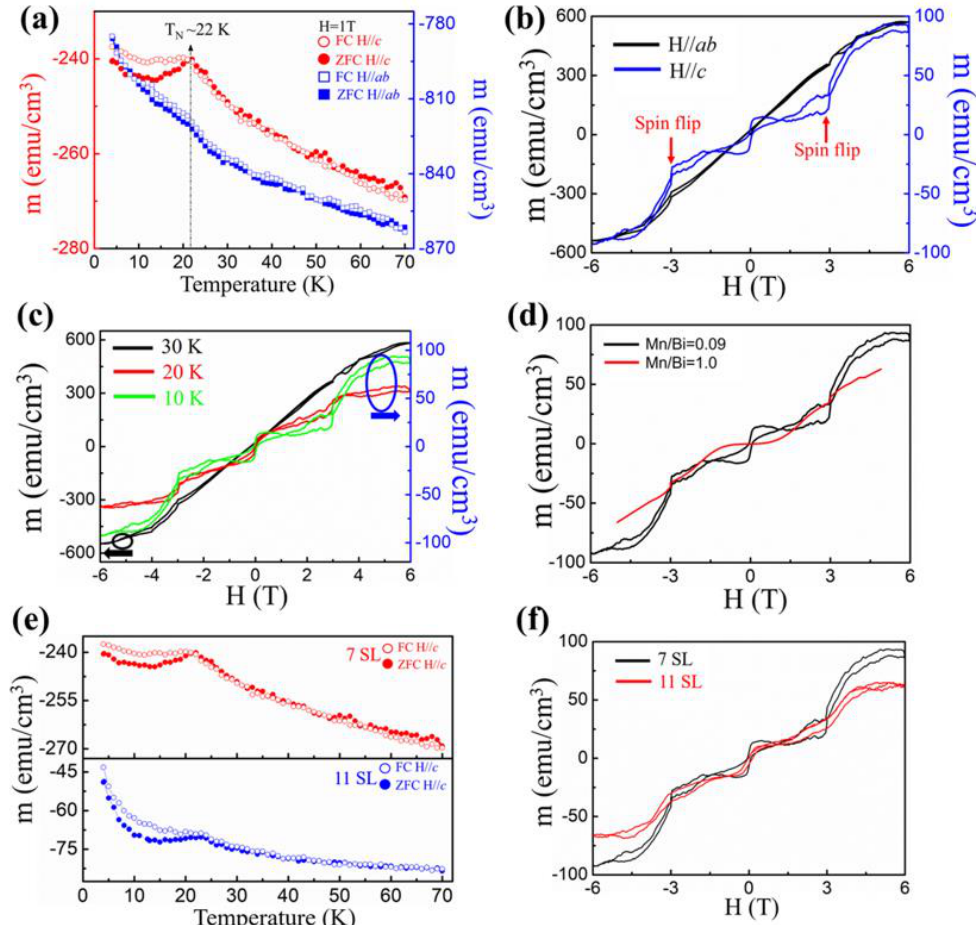
Figure 3. The magnetic properties of a 7 SL MnBi 2 Te 4 film. ( a ) The temperature dependence of the magnetic moment under ZFC and FC processes with magnetic fields out of plane ( H // c ) and in plane ( H // ab ), respectively. ( b ) The field dependence of the magnetization of a film measured at 10 K with magnetic fields out of plane ( H // c ) and in plane ( H // ab ), respectively. The red arrows indicate the spin-flip transition. ( c ) The field dependence of the magnetization of a film measured at various temperatures with a magnetic field applied out of plane ( H // c ). ( d ) The field dependence of the magnetization of a 7 SL MnBi 2 Te 4 film at 10 K when a magnetic field out of plane ( H // c ) was applied to samples with φ 𝑟 = 0.09 and φ 𝑟 = 1.0, respectively. ( e ) The temperature dependence of the magnetic moment under ZFC and FC processes with magnetic fields out of plane ( H // c ) for 7 SL and 11 SL, respectively. ( f ) The field dependence of the magnetization of 7 SL and 11 SL MnBi 2 Te 4 films at 10 K when a magnetic field out of plane ( H//c ) was applied to samples.